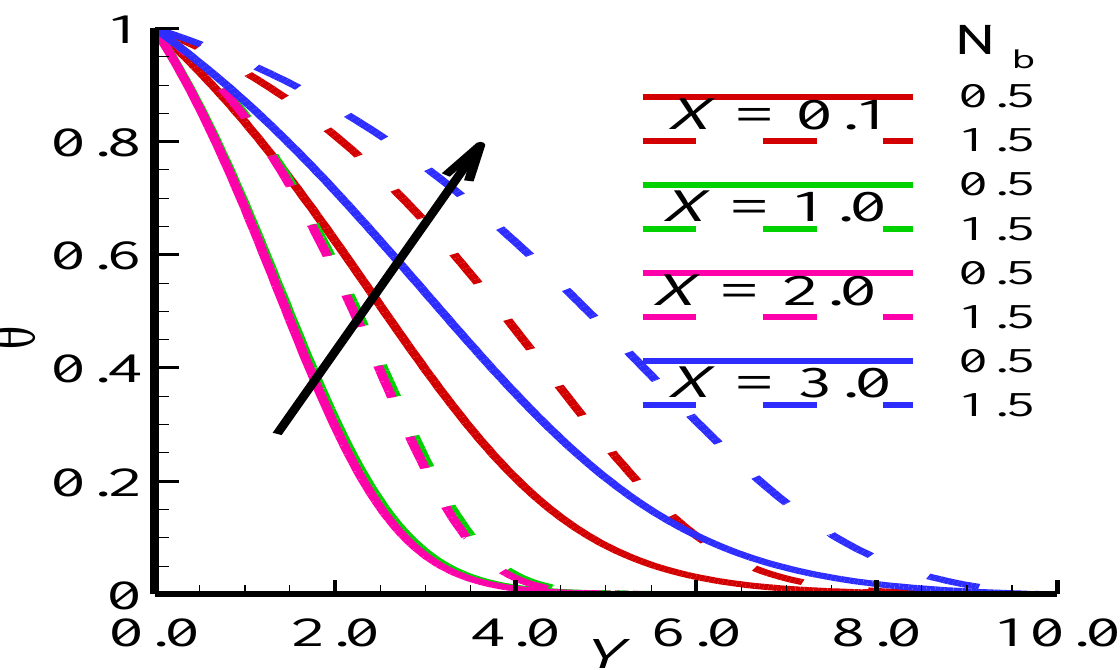
Figure 9. Outcomes of Brownian motion parameter 𝑁 𝑏 on temperature distribution 𝜃 when 𝑁 = 0.5,𝑃𝑟 = 7.0,𝑁𝑡 = 1.5 , and 𝑆𝑐 = 10.0.